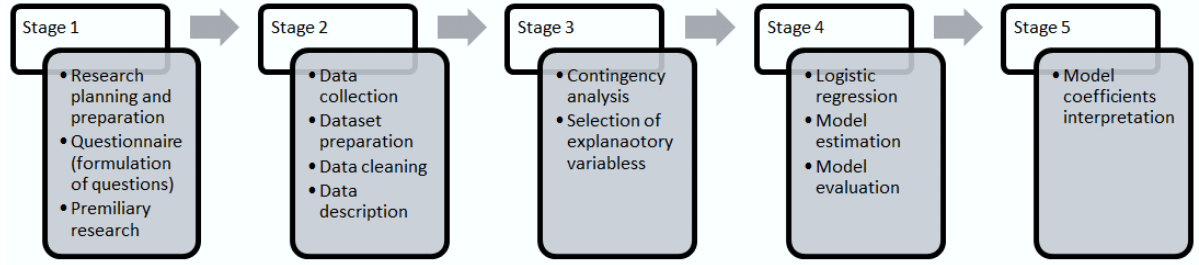
Figure 1. An overview of the stages of the